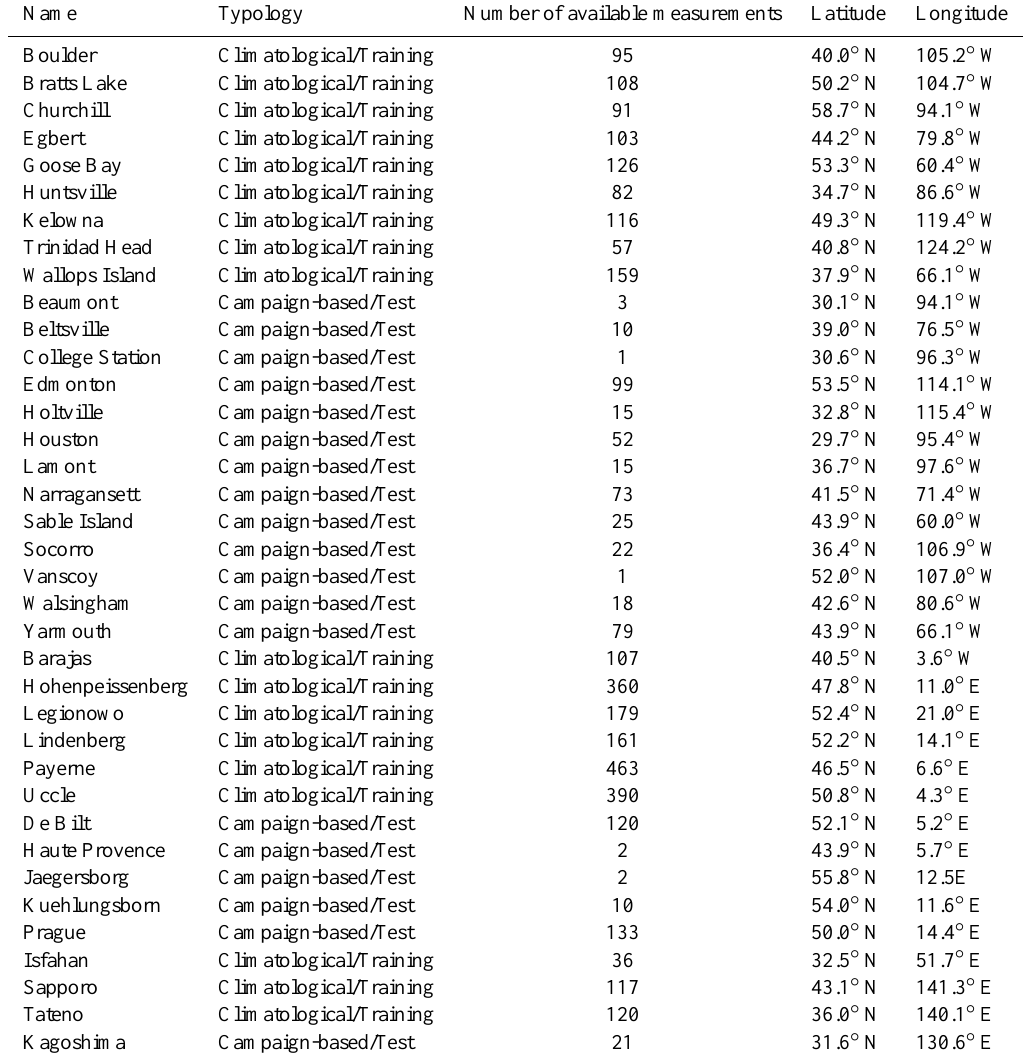
Table 1. Available OS